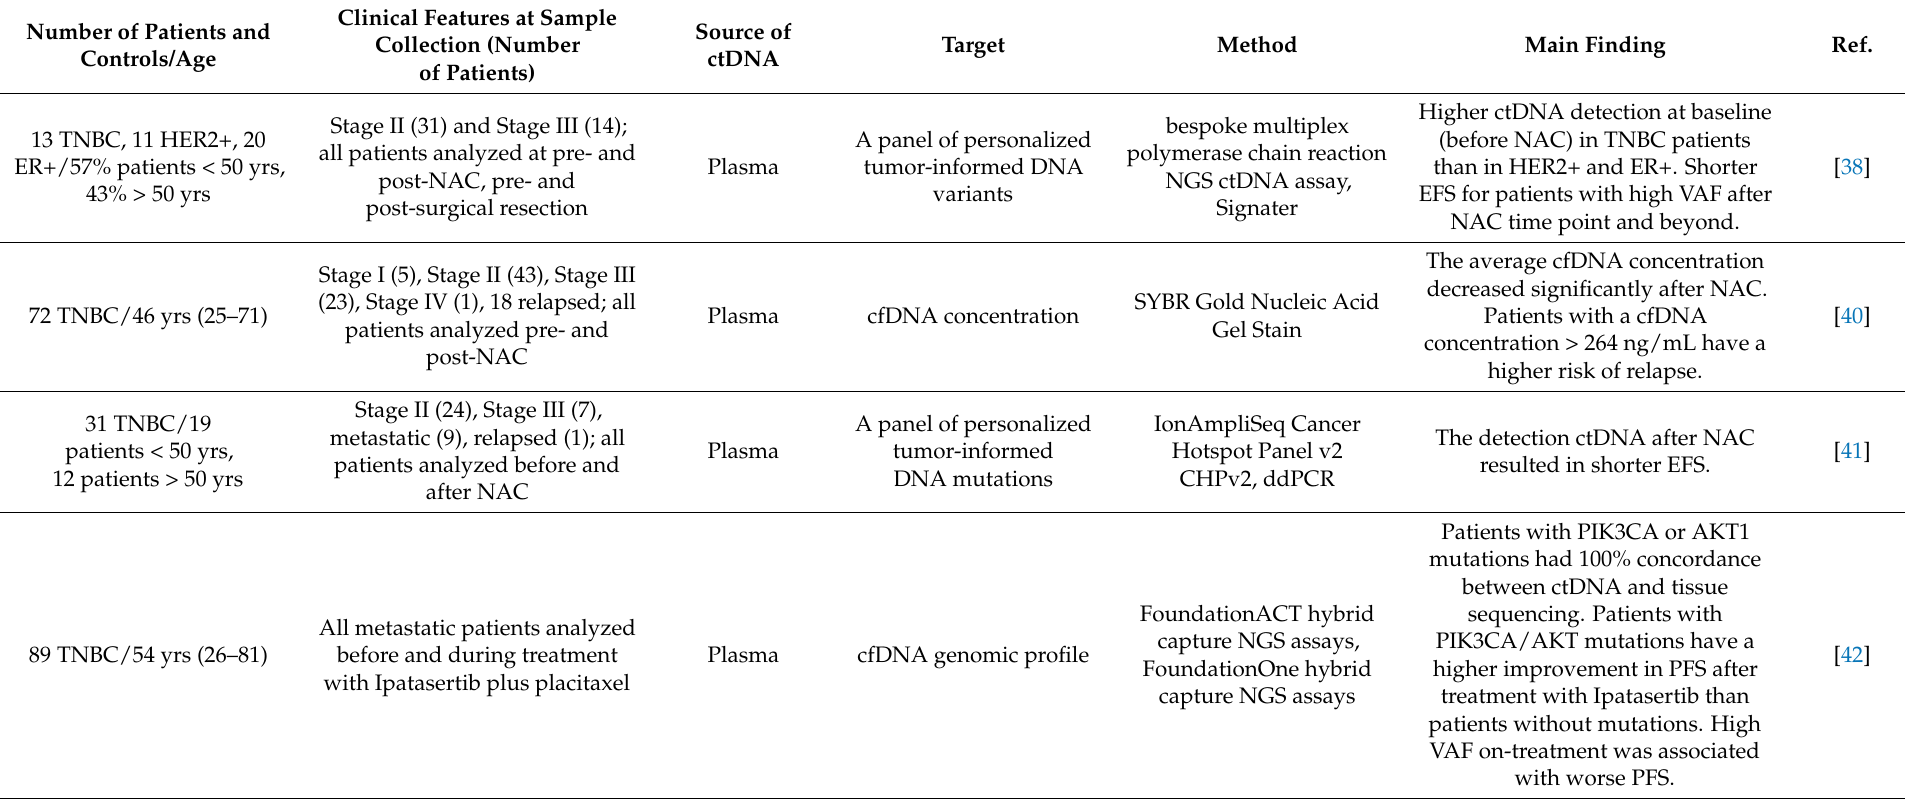
Table 1. Summary of clinical features of TNBC, experimental method, and main results in liquid biopsy on ctDNA. Abbreviations: cfDNA (circulating cell-free DNA); ctDNA (circulating cell-free tumor DNA); EFS (event-free survival); ER+ (estrogen receptor-positive breast cancer); HER2+ (HER2-positive breast cancer); HR+ (hormone receptor-positive breast cancer); MAF (mutant allele frequencies); NAC (neoadjuvant chemotherapy); OS (overall survival); PFS (progression-free survival); RFS (relapse-free survival); TNBC (triple-negative breast cancer); TFx (tumor fraction of cfDNA); VAF (variant allele frequencies); yrs (years). Staging refers to the first